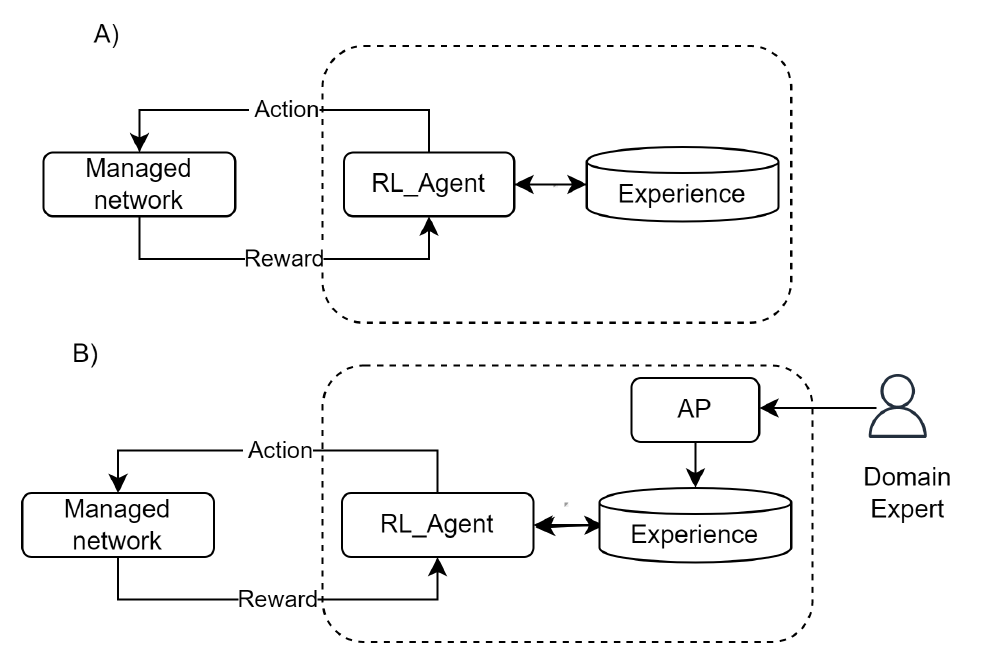
Figure 1. Integrating AP and